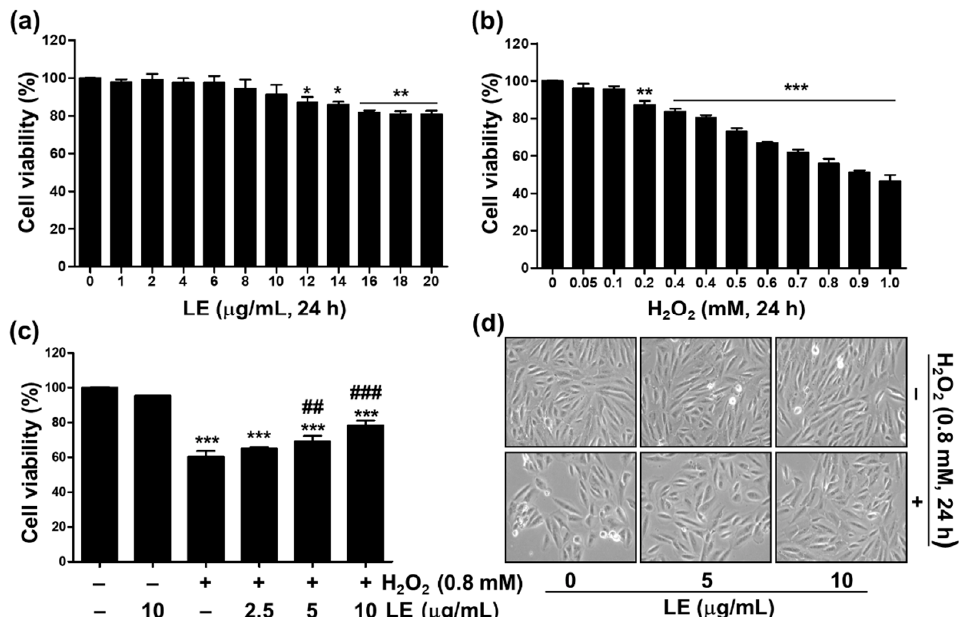
Figure 1. Effect of LE on H 2 O 2 -induced cytotoxicity in C2C12 cells. Cells were treated with various concentrations of LE ( a ) or H 2 O 2 ( b ) for 24 h or pre-treated, with or without the indicated diverse concentrations of LE for 1 h prior to exposure to 0.8 mM H 2 O 2 for 24 h ( c , d ); ( a – c ) Cell viability was assessed using a 3-(4,5-dimethylthiazol-2-yl)-2,5-diphenyltetrazolium bromide (MTT) assay. Data indicate mean ± SD values ( n = 3; * p < 0.05, ** p < 0.01, and *** p < 0.001 vs. control cells; ## p < 0.01 and ### p < 0.001 vs. H 2 O 2 -treated cells); ( d ) Effect of LE on morphological changes in H 2 O 2 -treated cells. Representative results from three independent experiments are shown.